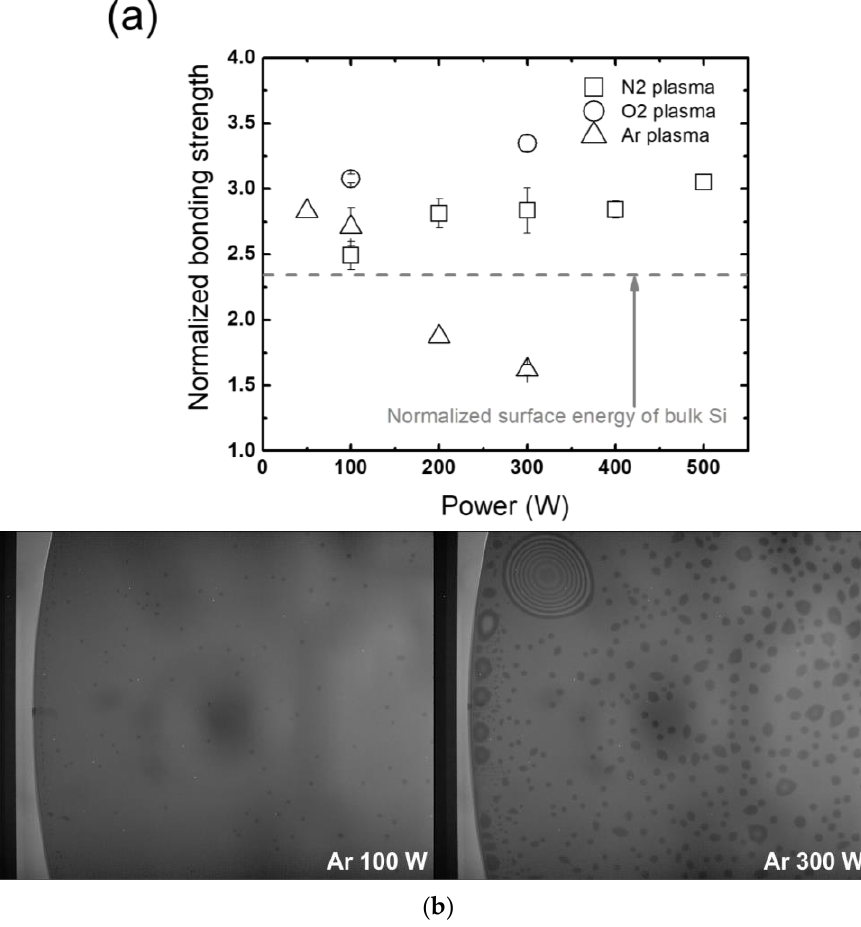
Figure 8. ( a ) Bonding strengths of wafer pairs under different plasma treatments with N 2 , O 2 , and Ar gases, and ( b ) IR images of the bonded interfaces under different plasma treatments with N 2 , O 2 , and Ar gases pictured before and after